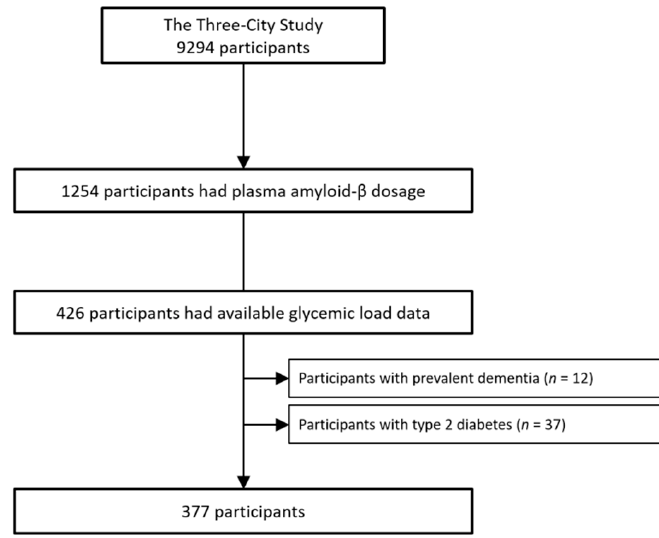
Figure 1. Flow Figure 1. Flow chart.